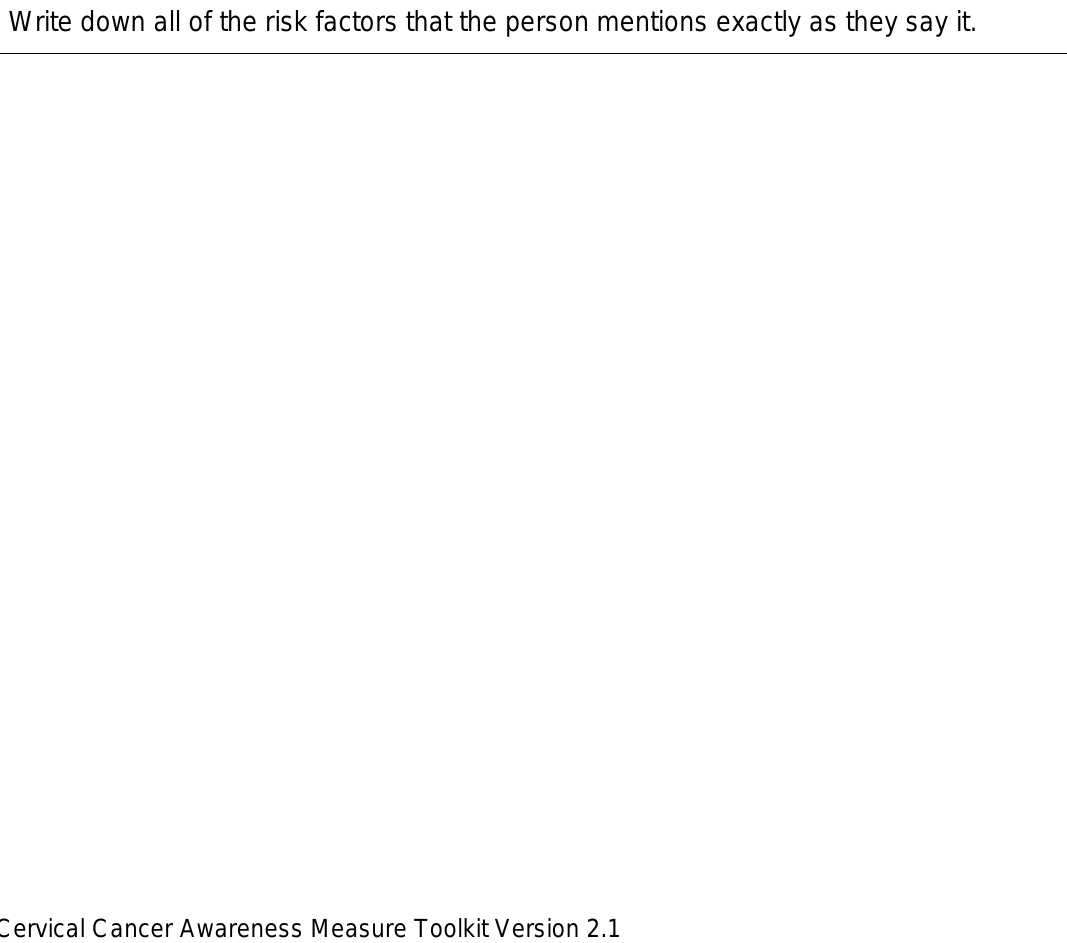
Cervical Cancer Awareness Measure Toolkit Version 2.1 Updated